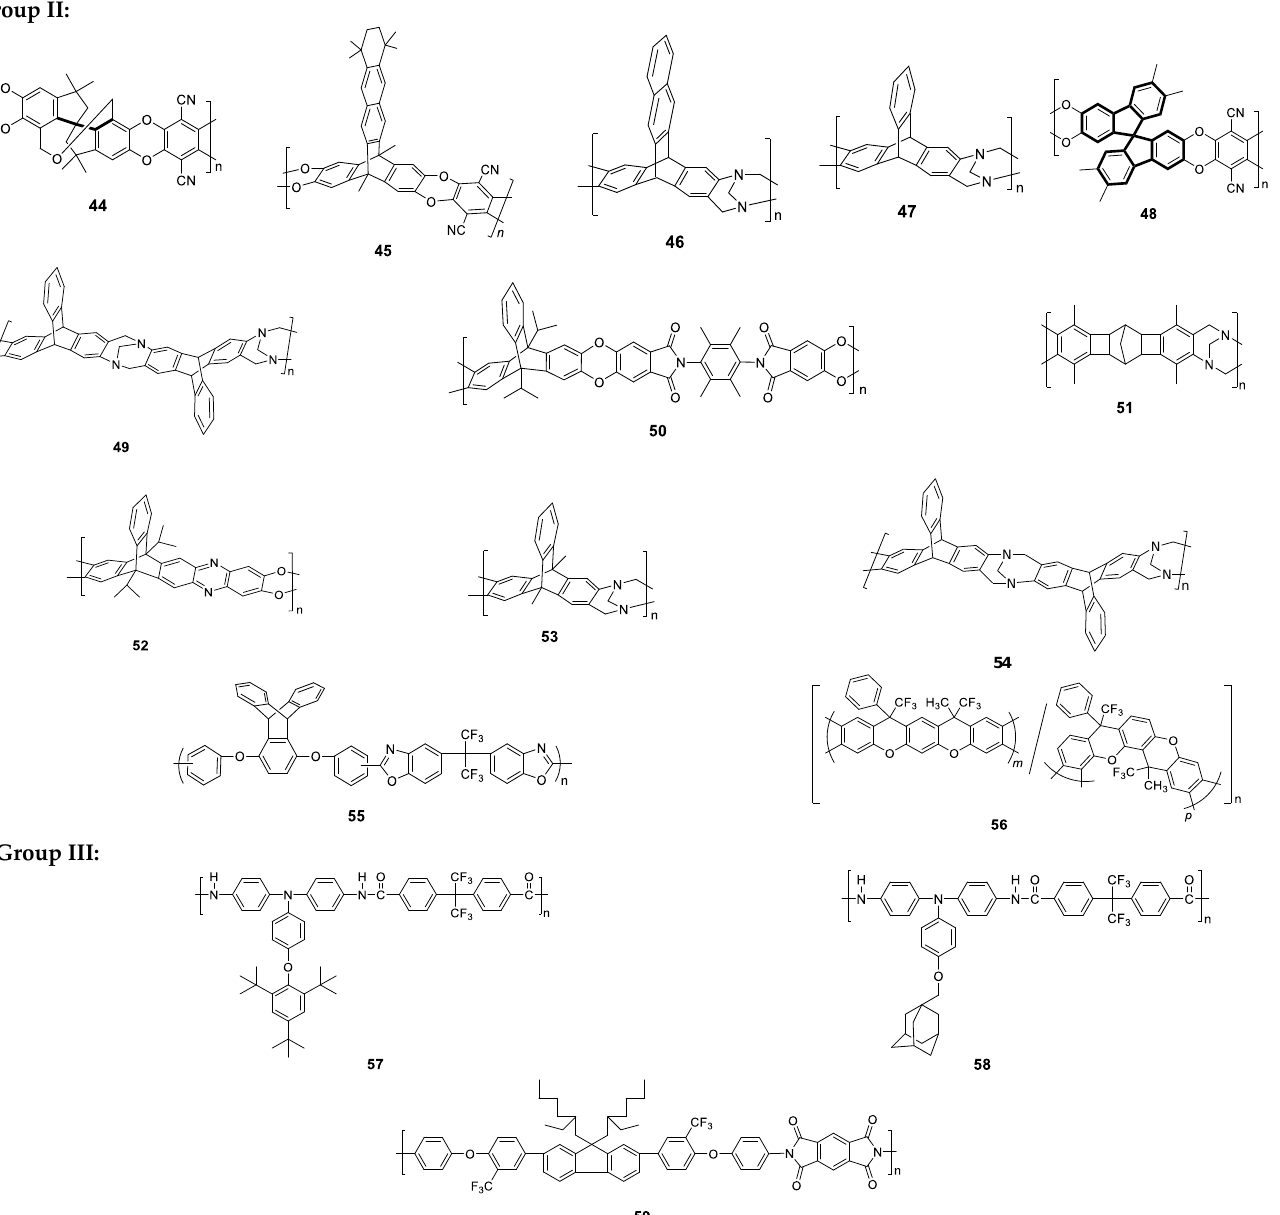
Figure 6. Plots of oxygen permselectivity through polymers, showing the highest α at each P O 2 reported in the literature in 2020 ( ● : after aging, ○ : before aging). For the data and categorization of the plots, see Table 4, and for the chemical structures of the polymers in the plots, see Charts 1 and 4. The small open circles indicate data in Figure 3. [Note] Please compare this figure with Figure 3. You can recognize a big advance between 2013 – 2020 and also no advance of polymers in Group I.